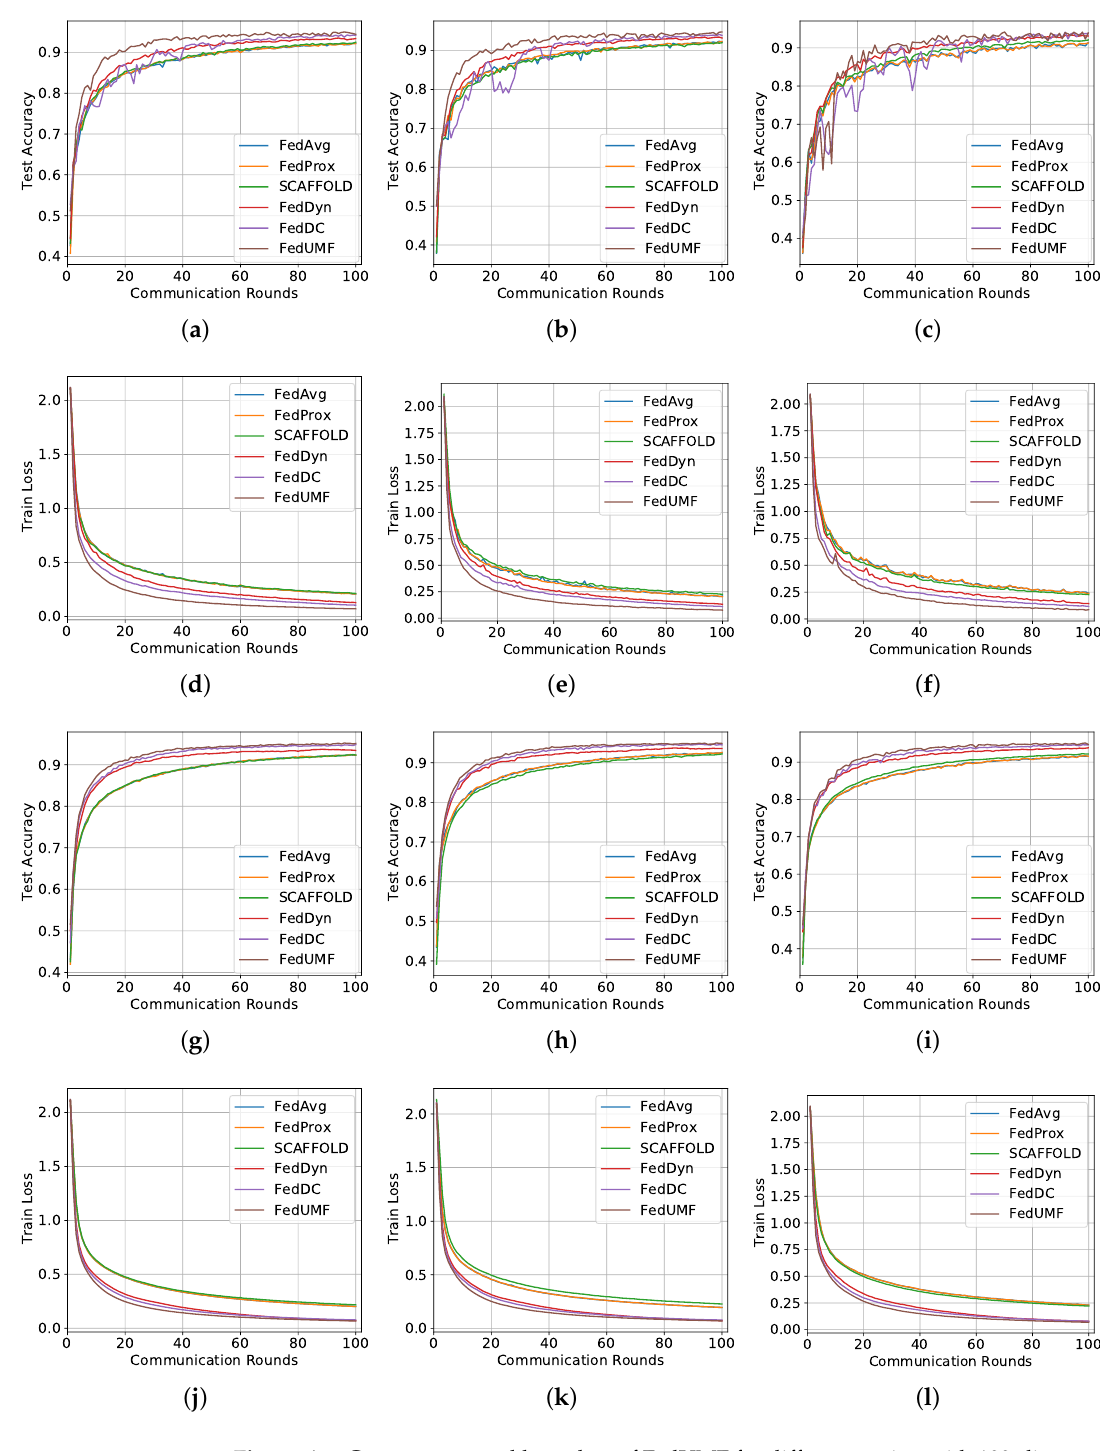
Figure A2. Convergence and loss plots of FedUMF for different setting with 100 clients adopting 15% and 65% client participating settings on EMNIST. ( a ) Test Acc. IID 15%. ( b ) Test Acc. unbalance 15%. ( c ) Test Acc. Drichlet 0.6 15%. ( d ) Train Loss. IID 15%. ( e ) Train Loss. unbalance 15%. ( f ) Train Loss. Drichlet 0.6 15%. ( g ) Test Acc. IID 65%. ( h ) Test Acc. unbalance 65%. ( i ) Test Acc. Drichlet 0.6 65%. ( j ) Train Loss. IID 65%. ( k ) Train Loss. unbalance 65%. ( l ) Train Loss. Drichlet 0.6